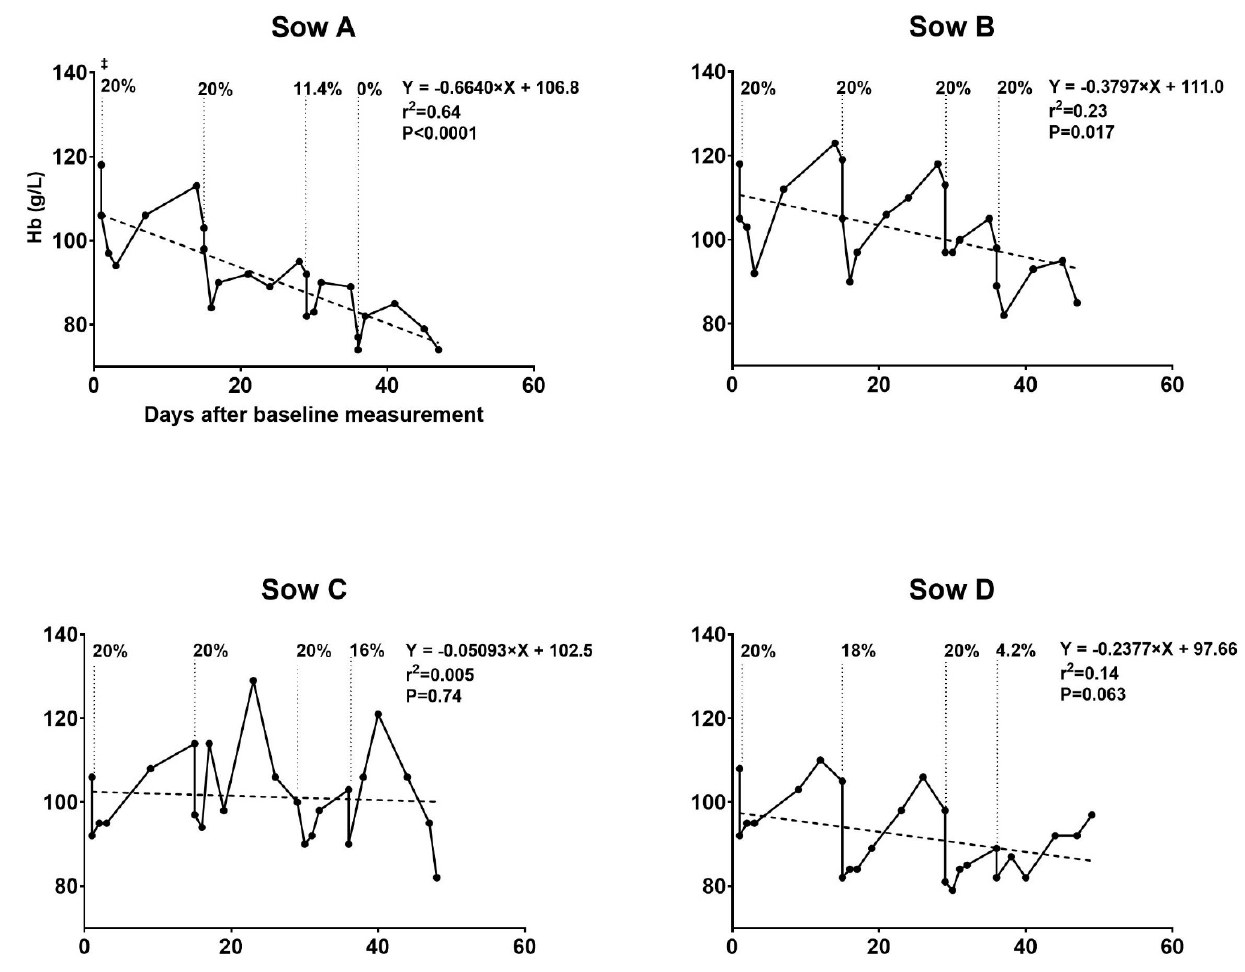
Figure 1. Blood hemoglobin (Hb) development during the experiment for the blood removal group in trial I. Development in blood Hb levels in response to blood removal in gestational sows fed an iron-reduced diet. Four sows were subjected to four rounds of blood removal from gestation day 71–72. ‡ Percentages of total blood volume removed at each procedure illustrated by the dotted line. The target Hb level at blood removal was 80 g/L. If Hb was 80 g/L before the procedure (measured with hemocue), no blood was removed (Sow A, fourth blood removal). A maximum of 20% of the blood volume was removed during each procedure. The regression line illustrates the gradual decrease in Hb over time. The low coefficient of determination in Sow B, C and D reflects the high increases in Hb as it is replenished just after the first three blood removal procedures.